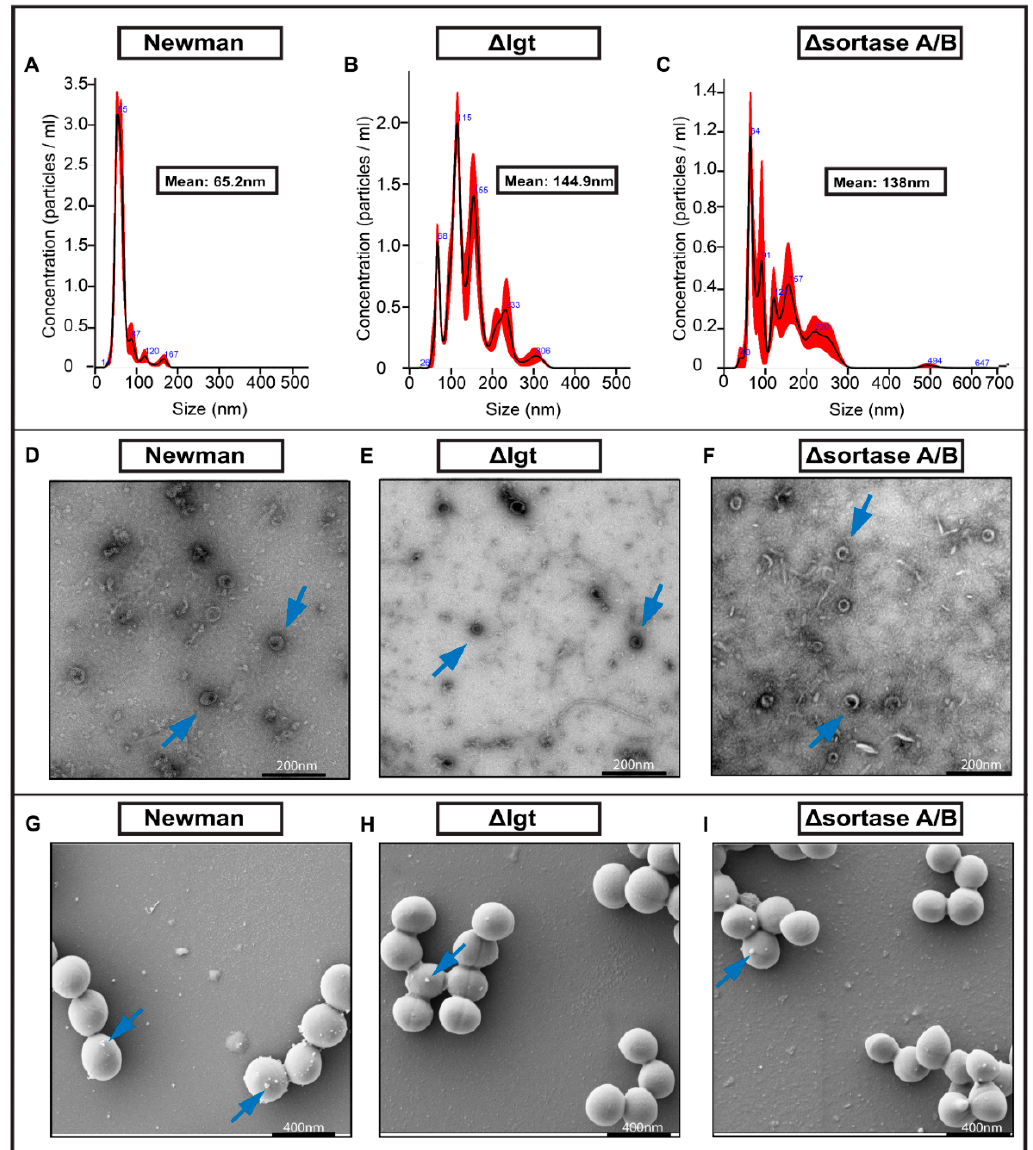
Figure 4. Characterization of extracellular vesicles (EVs). The size distribution of isolated EVs from Newman, Newman Δ lgt , Newman Δ srtAB ( A – C ). EVs were assessed for their size (nm) and concentration (particles/mL) using LM10 (Malvern Panalytical). Four independent measurements (biological replicates) were performed in scatter mode. Measurement readings for each EV sample were taken via five captures for 60 s each at 25 frames per second (fps), at adjusted camera levels (10–16) and detection thresholds (5–15) depending on the individual sample and manual monitoring of temperature. Electronic microscopy images of the isolated EVs ( D – F ) and presence of EVs in 3 h bacterial culture from Newman and mutant strains respectively ( G – I ). Arrow in ( D – F ) indicates EVs, while in the ( G – I ) images, budding-like dots indicate EVs on the cell surface of S. aureus .